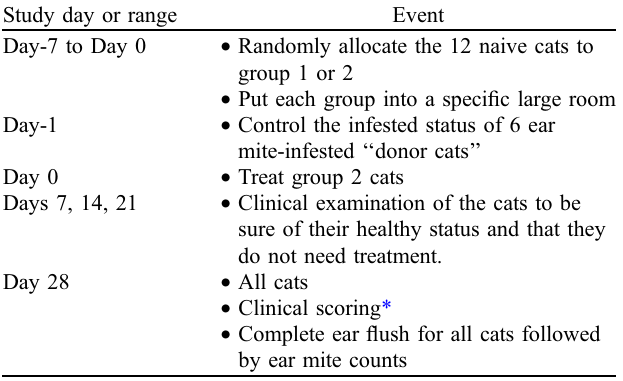
Table 1. Design of the